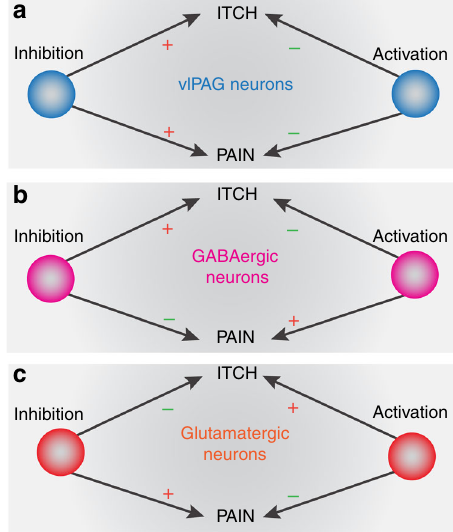
Fig. 10 Summary of the effects of manipulation of global vs. cell type- speci fi c activity in the vlPAG on pain and itch. a Global (non-cell-type- speci fi c) chemogenetic activation of vlPAG neurons resulted in robust suppression of itch and pain, while global chemogenetic inhibition of vlPAG neurons resulted in profound increases in itch and pain